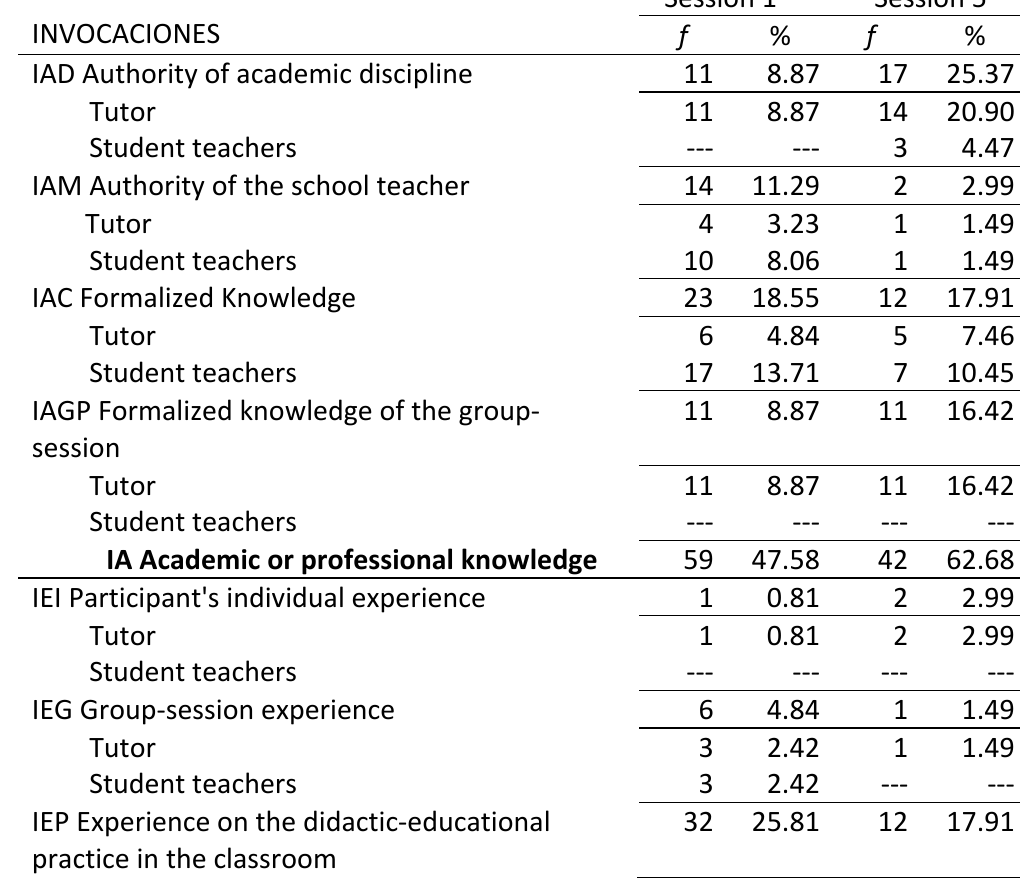
Table 8. Profile of invocations according to the session and the agent for case